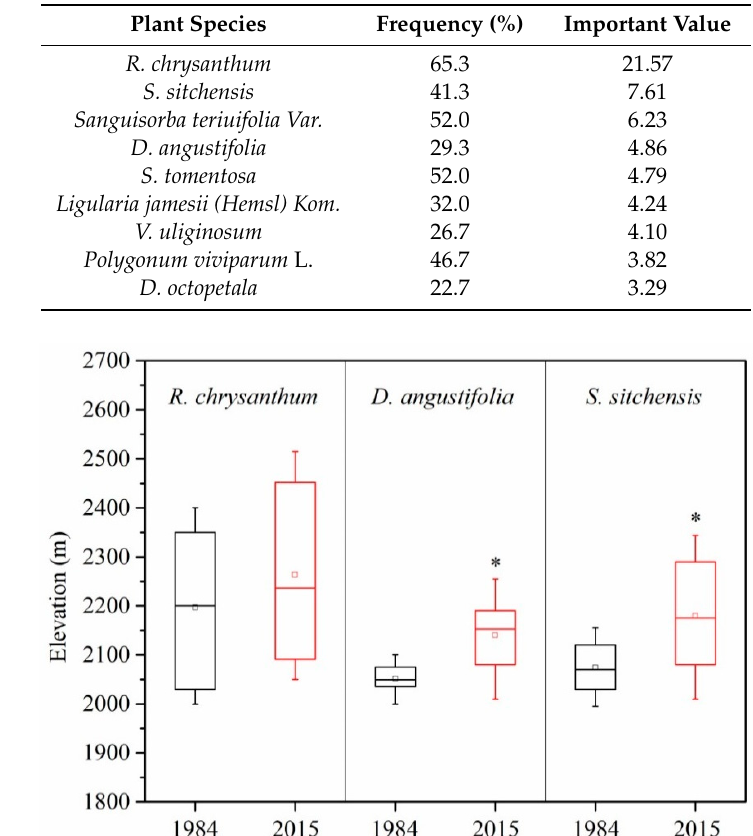
Table 2. The frequencies and important values for dominant species recorded within the Changbai Mountains (2015).